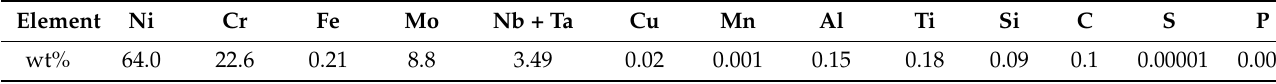
Table 1. Chemical composition of Inconel 625 wire used in this study.